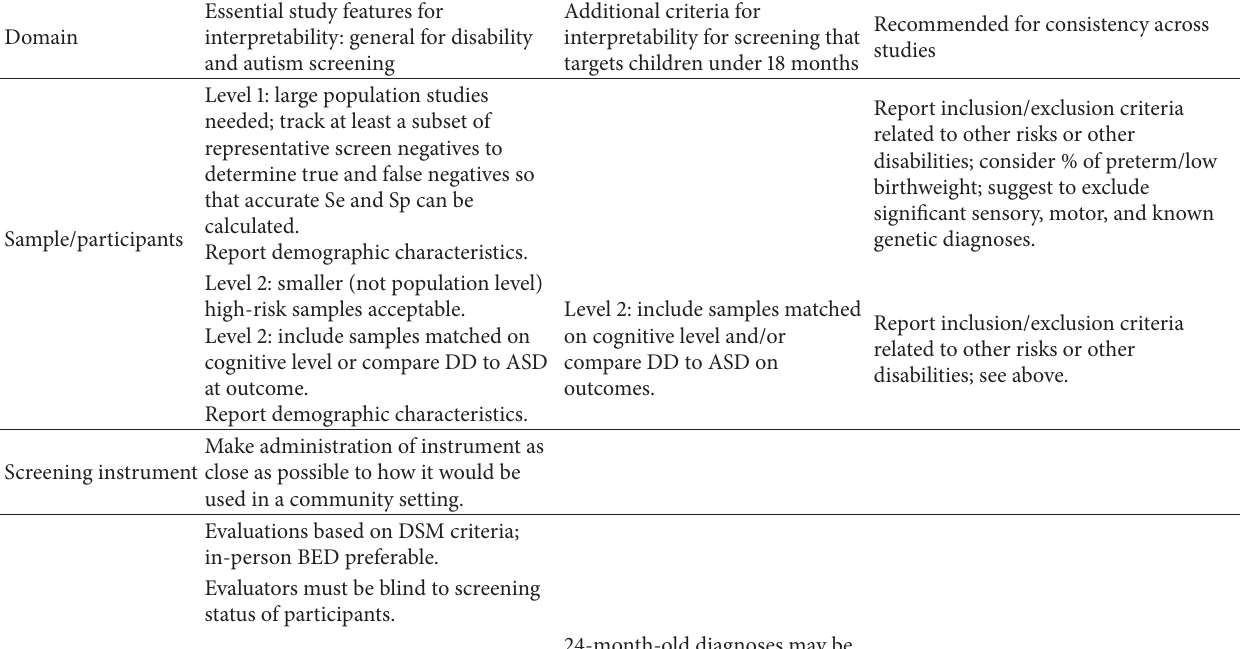
Table 7: Methodological recommendations for future early autism screening